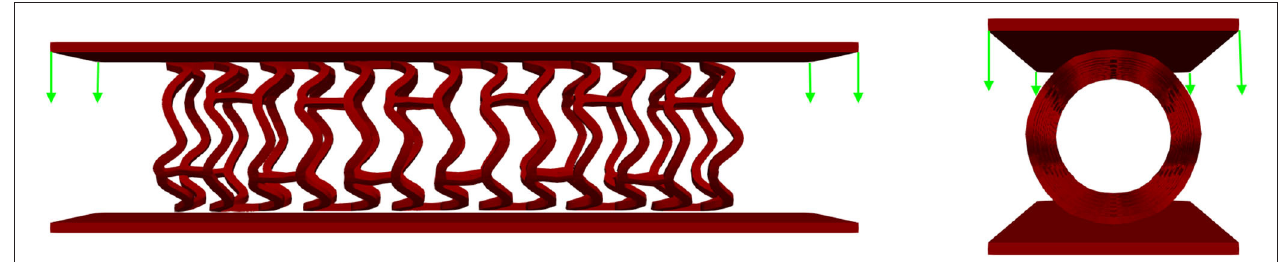
FIGURE 12 | Boundary conditions of crush test. The stent is positioned between two plates: the top plate is loaded by uniform force while the bottom plate is fixed for displacements.